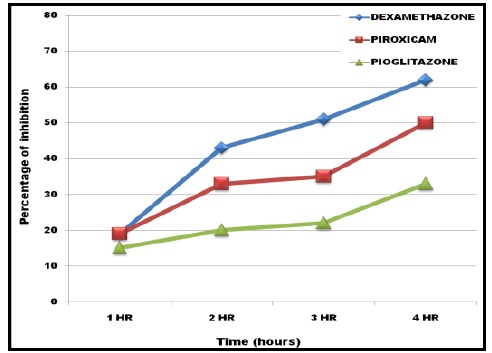
Figure 1. Effect of Pioglitazone on egg albumin-induced acute inflammation in